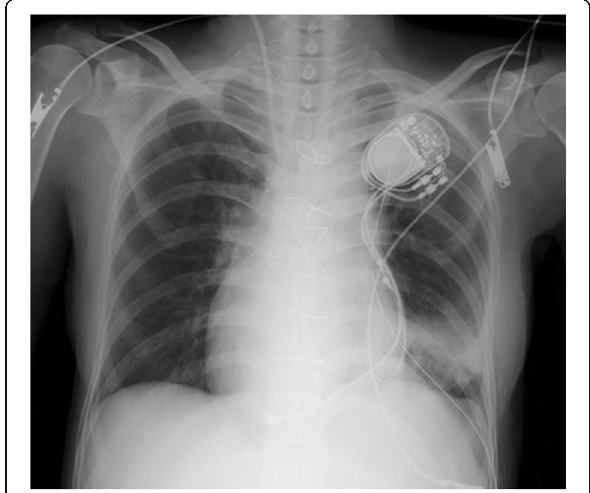
Fig. 4 The postoperative chest X-ray after the extubation showing the successful re-expansion of the left